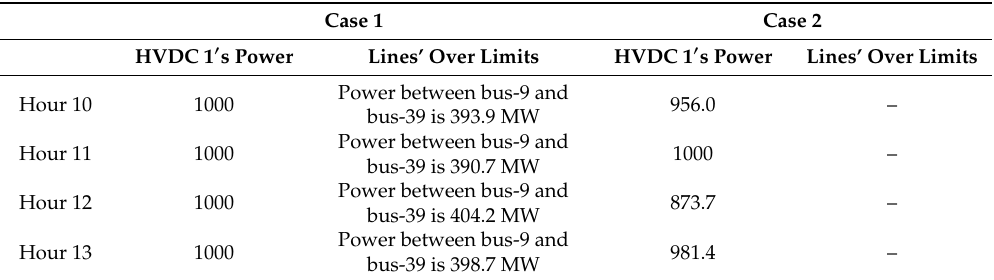
Table 2. HVDC 1 transmission power and AC transmission power HVDC1 block fault.